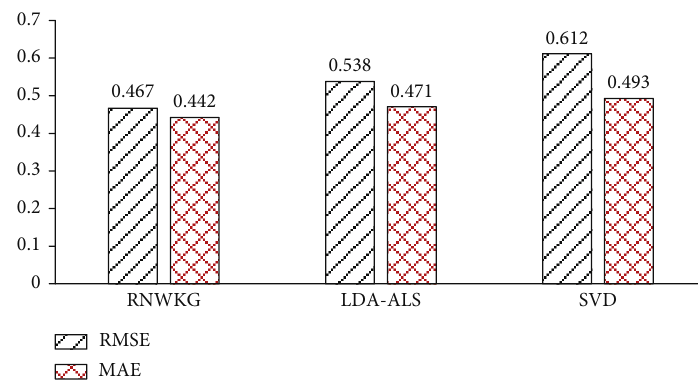
Figure 11: Performance comparison of three recommended